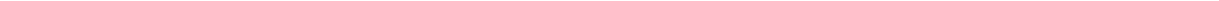
Fig. 7 MiR-128 deletion promotes proliferation of adult CMs. a Schematic diagram depicting the protocol of tamoxifen (TAM)-inducible miR-128 deletion (iKO) in adult hearts (P28). Control (Ctrl) mice were miR-128 fl / fl mice, and iKO mice were α -MHC MerCreMer ; miR-128 fl / fl mice. b WGA staining in adult control and iKO hearts. Scale bars, 50 µ m. c Measurement of HW to BW ratio in control and iKO hearts ( n = 6). d Quanti fi cation of CM size determined by WGA staining ( n = 6 mice, ~150 CMs/heart). e Evaluation of CM proliferation by EdU incorporation ( n = 1130 CMs pooled from fi ve mice). Scale bars, 25 µ m. f Representative images of isolated adult CMs in control and iKO hearts. Scale bars, 100 µ m. g Comparison of CM number in hearts from control and iKO mice. Approximately 2000 CMs were counted per sample, three independent samples per group. h Schematic diagram for the TAM-inducible dual- lineage tracing protocol for the mouse models. Control (Ctrl-tdTomato) mice were α -MHC MerCreMer ; Rosa tdTomato . The iKO-tdTomato mice were α MHC MerCreMer ; miR-128 fl / fl ; Rosa tdTomato . i qPCR analysis of miR-128 expression in Ctrl-tdTomato and iKO-tdTomato hearts ( n = 5). j Analysis of in vivo sarcomere structure of hears from Ctrl-tdTomato and iKO-tdTomato mice by immuno fl uorescence staining of cTnT ( n = 5). Scale bars, 10 µ m. k Expression of sarcomere genes, fetal genes, and genes associated with cell proliferation analyzed by qPCR in adult hearts from Ctrl-tdTomato and iKO-tdTomato mice ( n = 6). Statistical signi fi cance was calculated using Student ’ s t -test in b , d , e, g , i , and k . Data are represented as means ± SEM. * P < 0.05. NS,